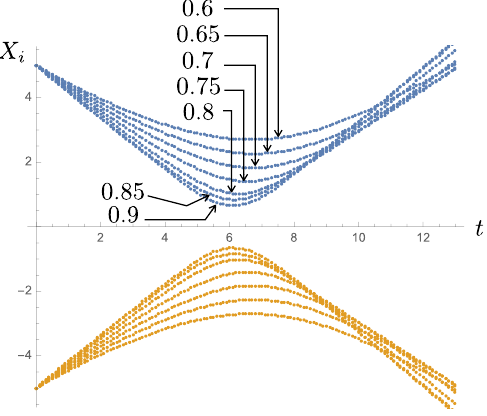
Figure 7 . The trajectories X i ( t ) of two anti-parallel vortices for u = 0 . 6 , 0 . 65 , 0 . 7 , 0 . 75 , 0 . 8 , 0 . 85 , 0 . 9 . We do not show Y i ( t ) because it always